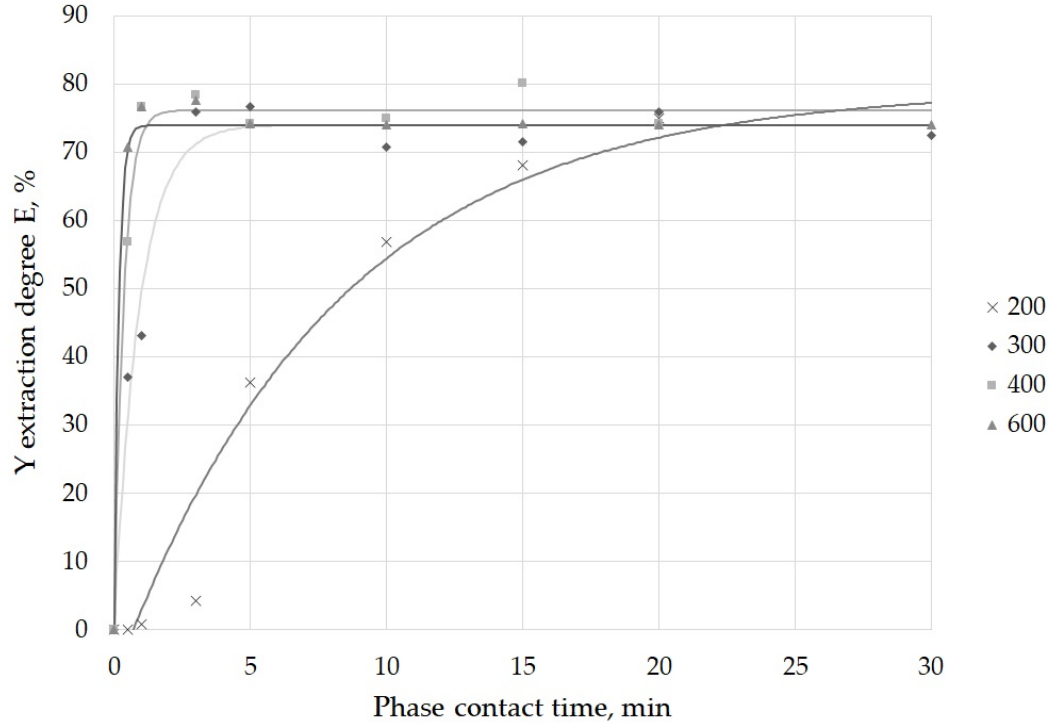
Figure 1. The dependences of the yttrium extraction degree on the phase contact time at different stirring rate in revolutions per minute (RPM) under temperature of 300 K.